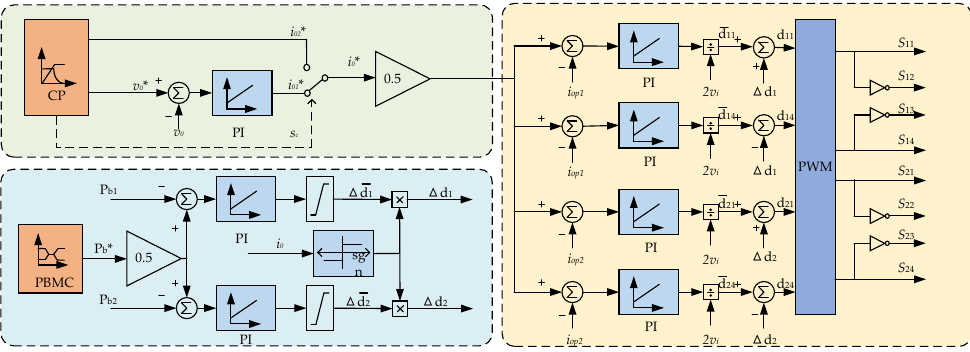
Figure 17. Fast-charging method with comprehensive DC power-balance management.